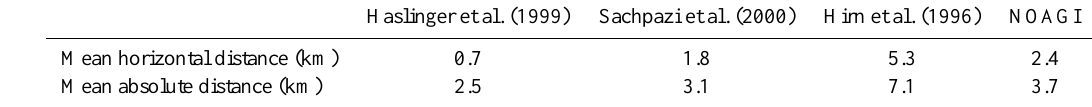
Table 3. Mean horizontal and absolute source location distances between the adopted model and the other seismic velocity models.